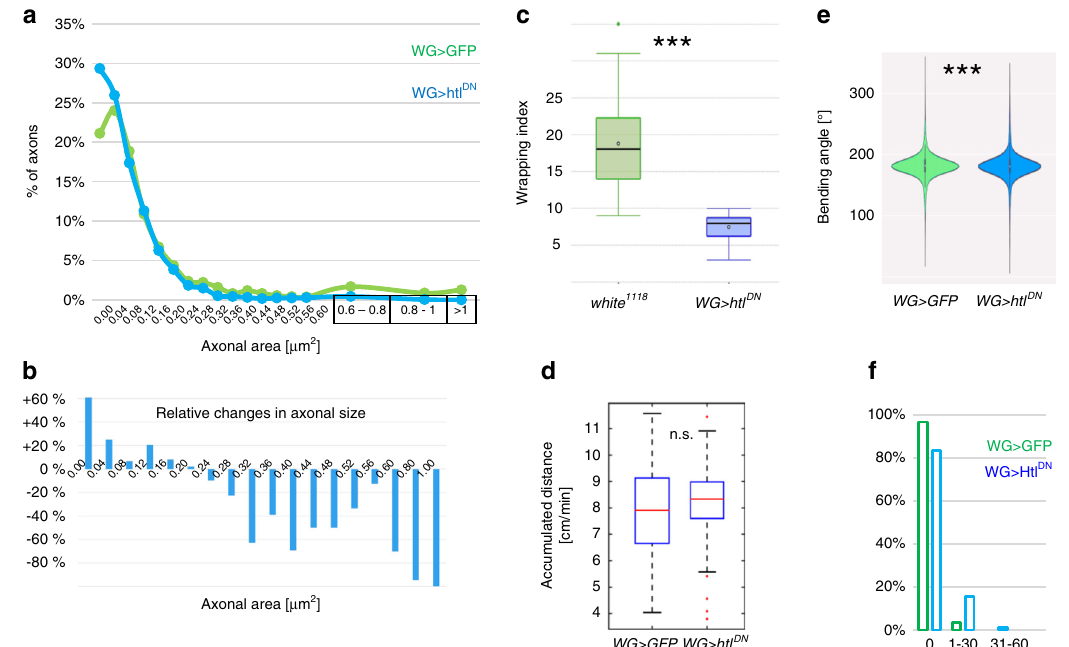
Fig. 3 Wrapping glia affects neuronal differentiation and behavior. a Distribution of axonal size in 40nm 2 bins of control larvae ([ nrv2-Gal4, UAS-GFP; 90C03-Gal80/90C03-Gal80 ], 2046 axons of 26 nerves) and of larvae expressing htl DN in wrapping glia ([ nrv2-Gal4/UAS-htl DN ; 90C03-Gal80/90C03-Gal80 ]; 2555 axons of 22 nerves). The number of axons in the indicated size intervals is plotted for control (green) and htl DN nerves (blue). b Same dataset as in ( a ). Relative changes in the number of axons in different axon size classes upon expression of htl DN compared to control animals. Note the increase in the number of small diameter axons and the reduction of larger caliber axons. c The wrapping index of control larvae [ white 1118 ] and larvae expressing htl DN in the wrapping glia [ nrv2-Gal4; UAS-htl DN ]. The wrapping index in control nerves is 18.5 ( n = 27 nerves). The wrapping index is 7.5 upon heartless suppression ( n = 22 nerves, p = 3.5E − 11, t test). d The accumulated distance per minute is not changed by expression of htl DN (genotypes as indicated). n = 68 control larvae and n = 71 larvae expressing htl DN , p = 0.85, Wilcoxon rank-sum test. Box plots in ( c , d ) show median (horizontal line), boxes represent the fi rst and third quartile, whiskers show standard deviation, individual points show outliers. e Bending angle distribution of control larvae and larvae expressing htl